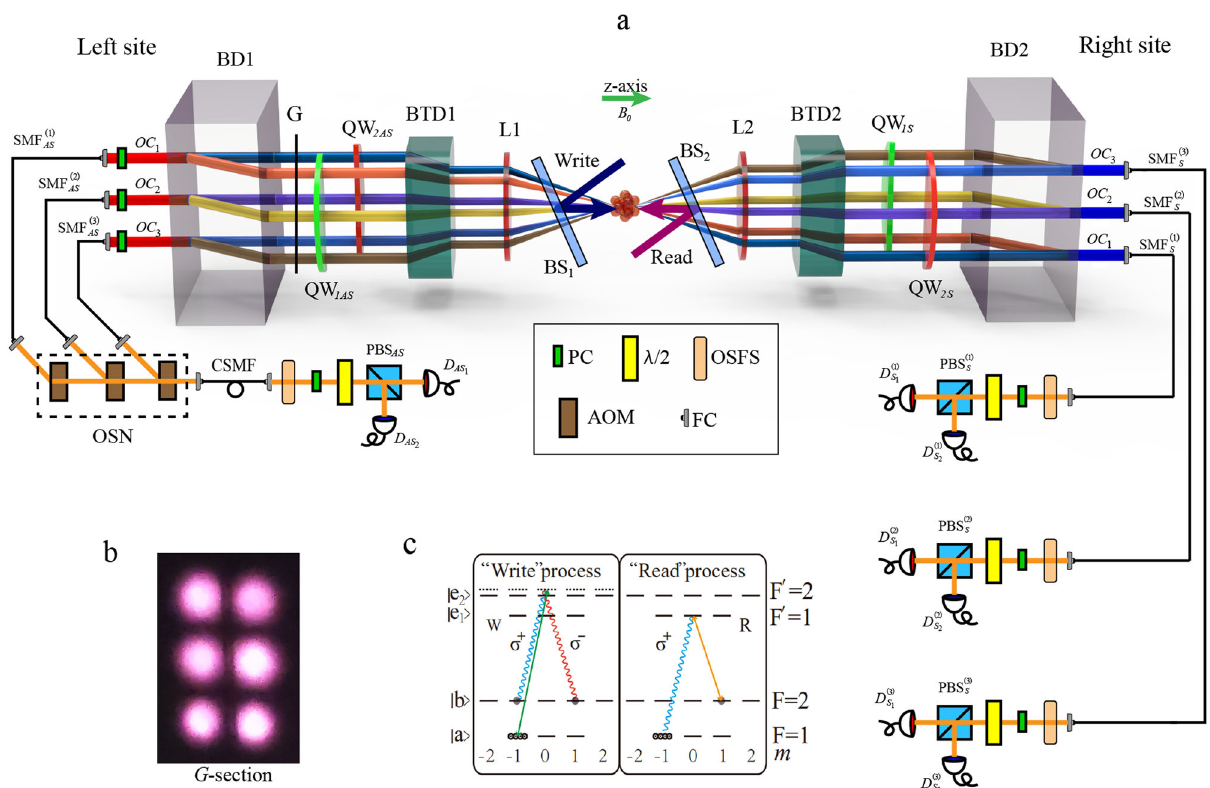
Fig. 1 Overview of the experiment. a Experiment setup for the three-mode MQI (multiplexed quantum interface). PC: phase compensator ( “ Methods ” section); CSMF: common single-mode fi ber; OSN: optical switching network; QW: λ /4 wave-plate; BD: beam displacer, PBS: polarization-beam splitter; BTD: beam transformation device; SMF: single-mode fi ber; OC: optical channel. BS 1 (BS 2 ): Non-polarizing beam splitter, whose re fl ectance (transmission) is 10% (90%). The write beam is aligned along the z -axis via BS 1 , and the read beam along the opposite direction to that of the write beam via BS 2 ; AOM: acoustic-optic modulator; FC: fi ber coupler; OSFS: optical-spectrum- fi lter set ( “ Methods ” section). B 0 : bias magnetic fi eld (4G). b Pattern of the array at the G-section. c Relevant atomic